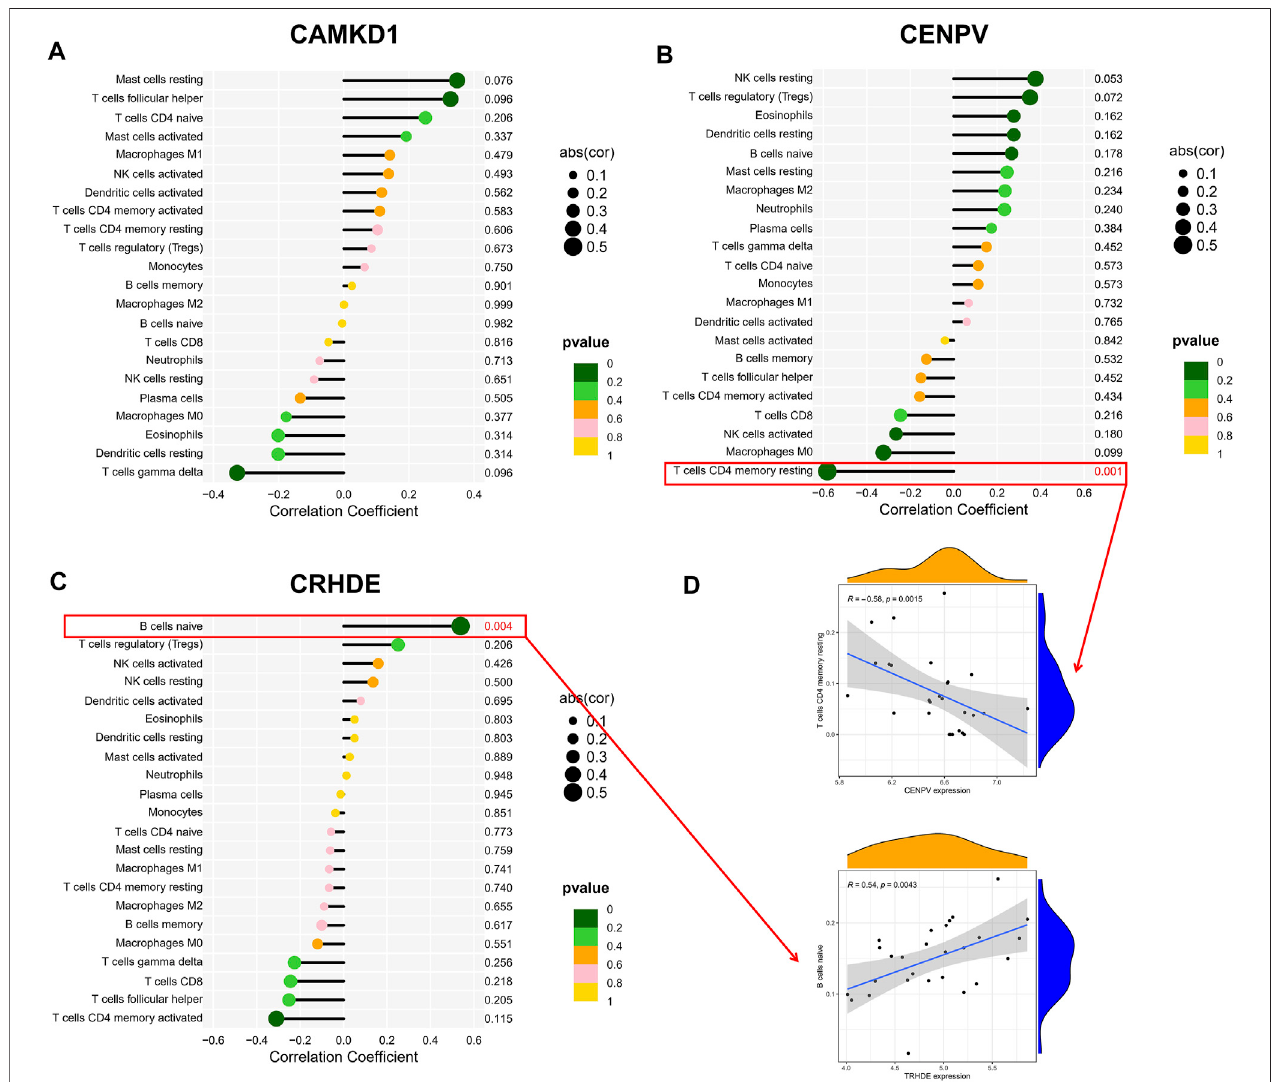
FIGURE 7 | Correlation hub biomarkers with immune-in fi ltrating cells. (A – C) Analysis ofthe correlation between the hub gene and immune cell content, with those markedinredindicatingastatisticallysigni fi cantcorrelationbetweenthegeneandimmunecells. (D) Onceagain,statisticallysigni fi cantcorrelationsweremadebetween hub genes and immune cell